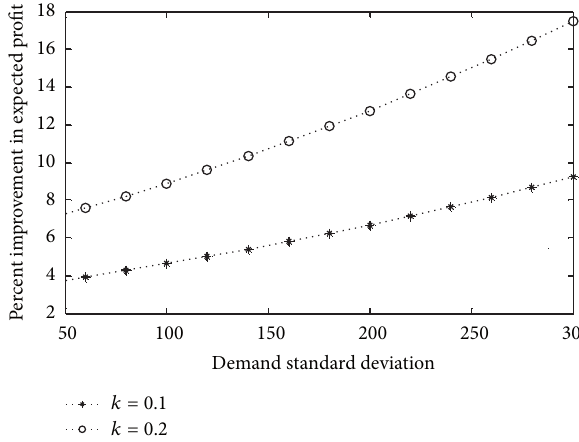
Figure 4: Percent improvement in the expected